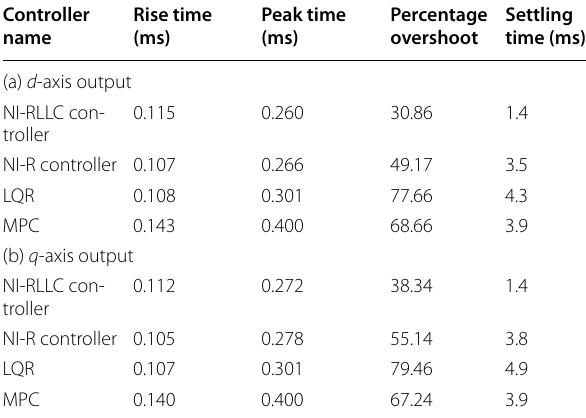
Table 6 Step response comparison of different controllers